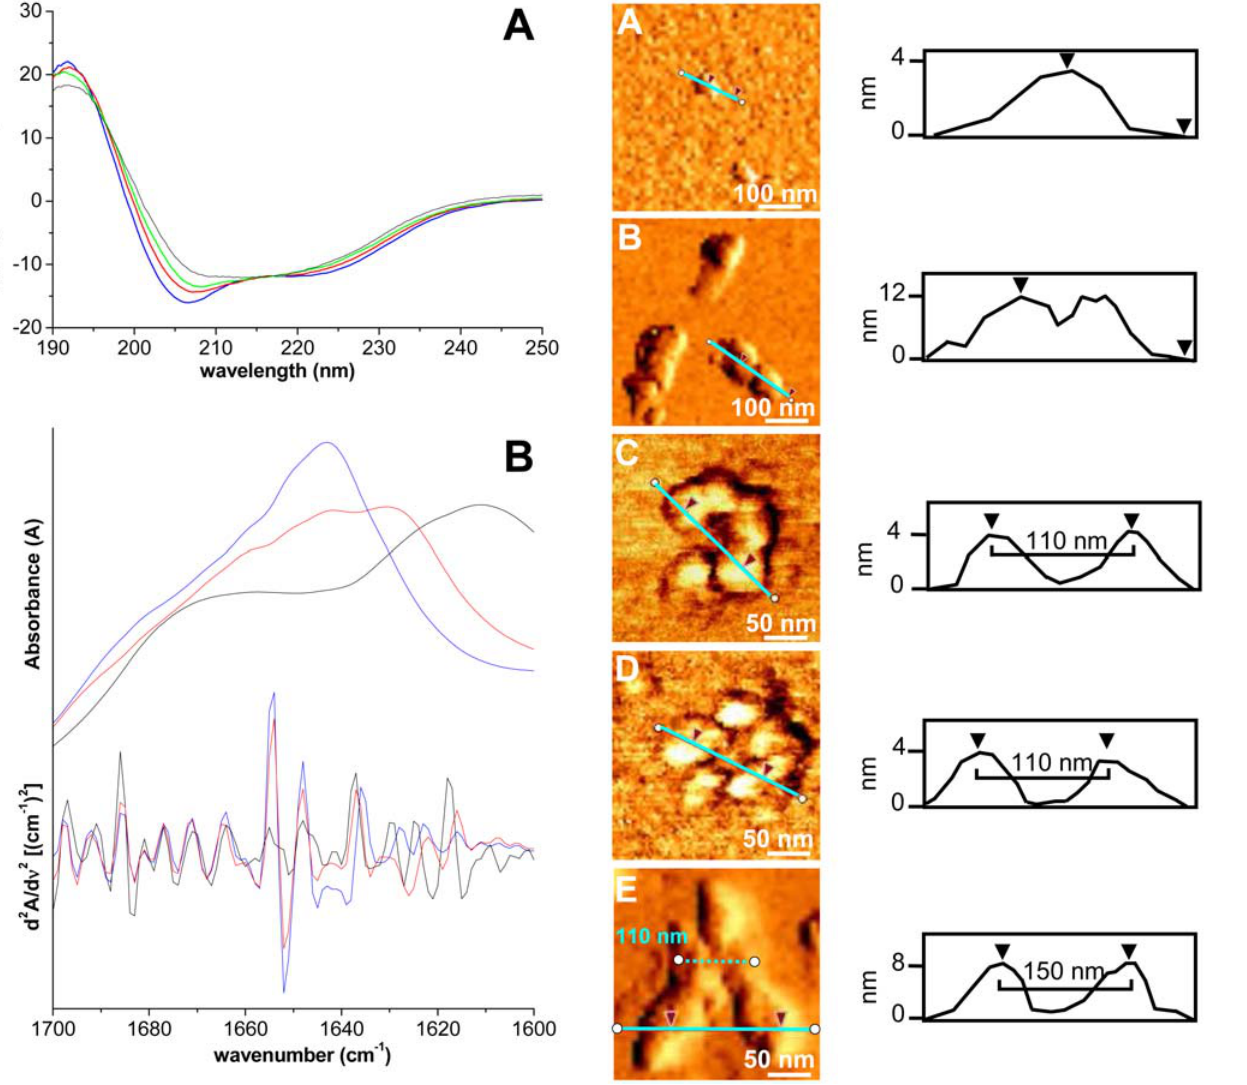
Figure 6. Hierarchical assembly of Ub aggregates. Phase-mode AFM images of Ub structures after incubation at 37 u C with 3 mol equiv of Cu II in 20% TFE for different time intervals: 1 d (A); 5 d (B); 10 d (C, D); 1 mo (E). ( Right panel ) Cross-sectional profile, taken along the cyan line, of the corresponding topographic image.